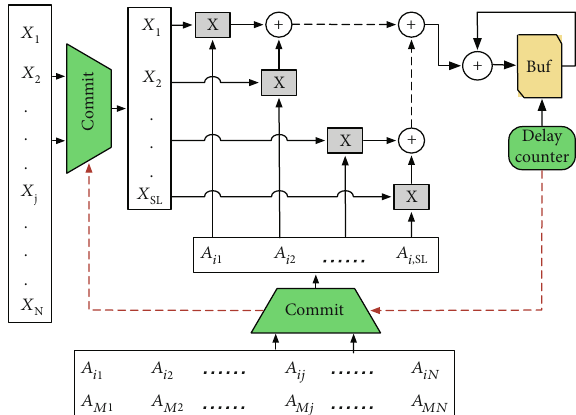
Figure 5: Segmented inner-product